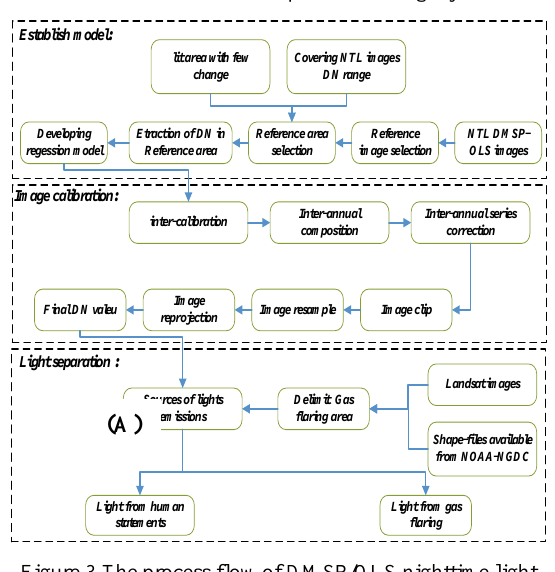
Figure 3.The process flow of DMSP/OLS nighttime light imagery.